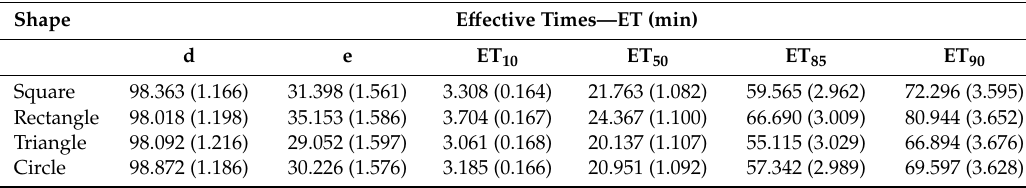
Table 1. Parameters of the non-linear asymptotic regressions (Equation (1)) and e ff ective times of cut estimated from the two-stage meta-analysis dose-response model (Figure 8 is a simplified graphical representation because the package ‘medrc’ does not draw the graph at the moment).